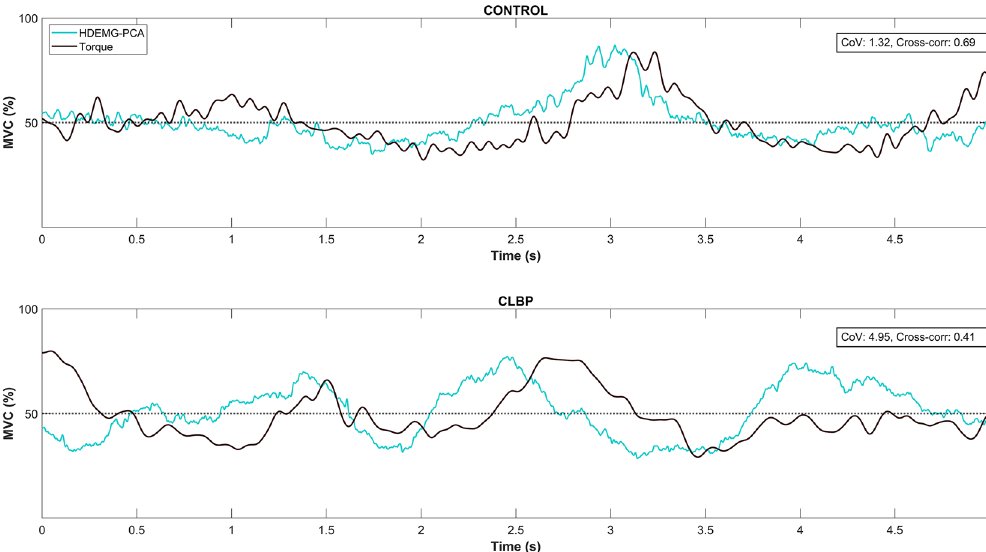
Figure 4. A sample outcome of lumbar extensor muscle torque steadiness assessment (5s window from the steady part of the contraction) for a control and a CLBP participant during the 50%MVC isometric back extension task. The black line represents the oscillations in torque for each participant, while the turquoise line represents the oscillations in the HDsEMG signal (i.e., the PCA-processed sEMG signal envelope). Note that the control participant has greater torque steadiness and at the same time a higher sEMG-torque cross-correlation, while the CLBP participant presents with lower torque steadiness performance and has a lower sEMG-torque cross-correlation at the same time.